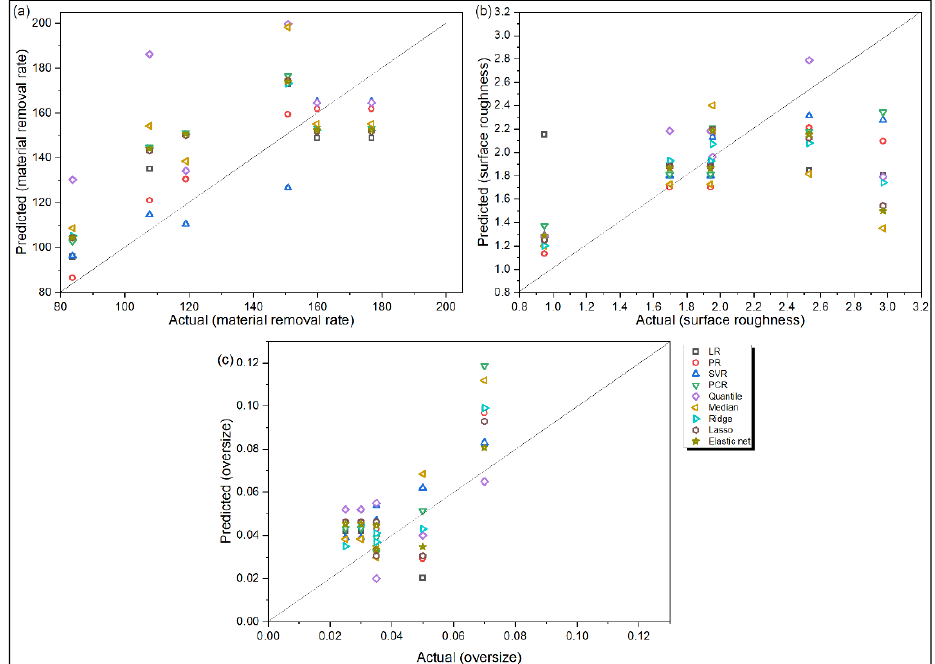
Figure 4. Actual versus predicted responses for drilling ( a ) MRR ( b ) Ra and ( c ) OS.